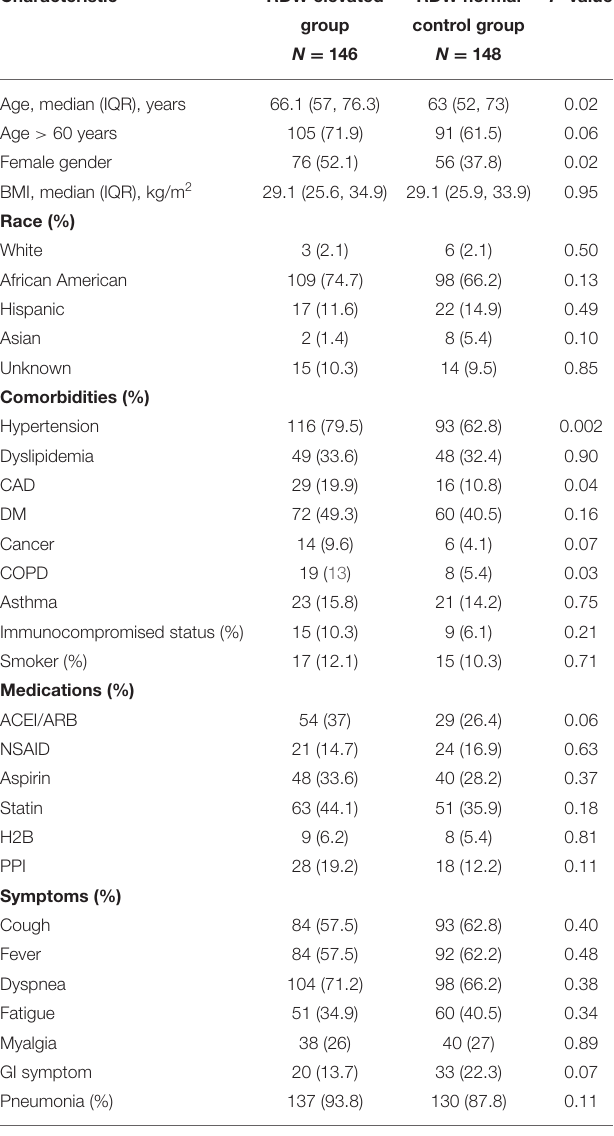
TABLE 1 | Baseline demographics of the study population e . Characteristic